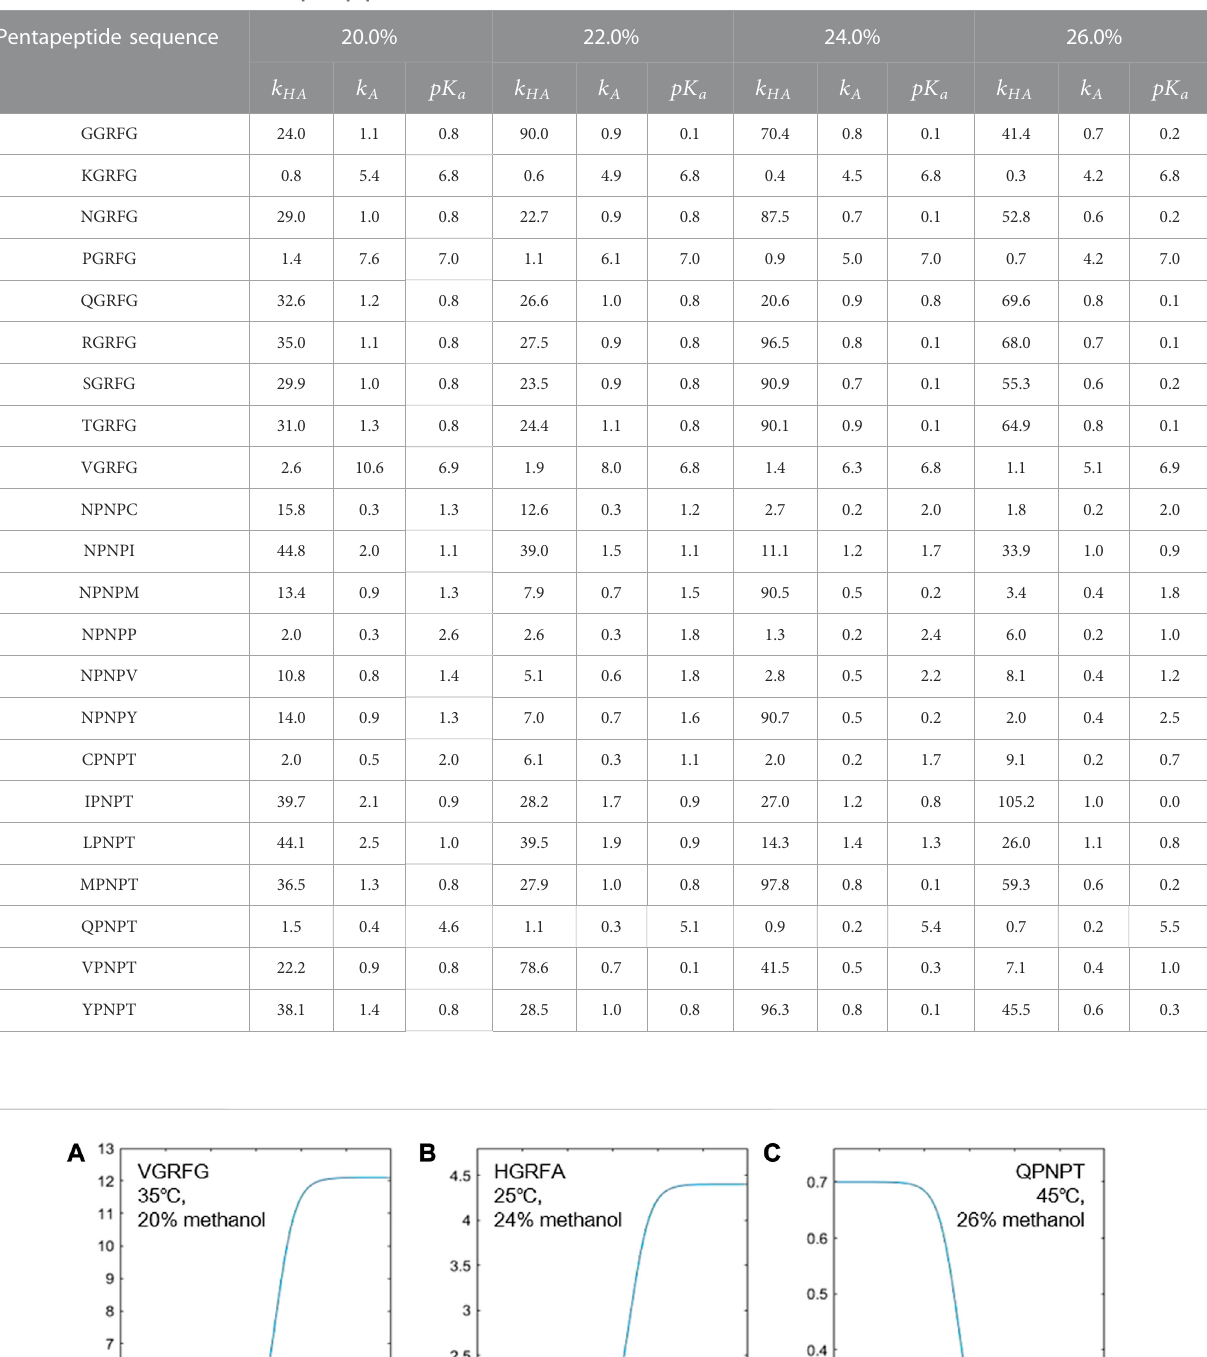
TABLE 4 ( Continued ) Parameter results of pentapeptides at 45 ° C.